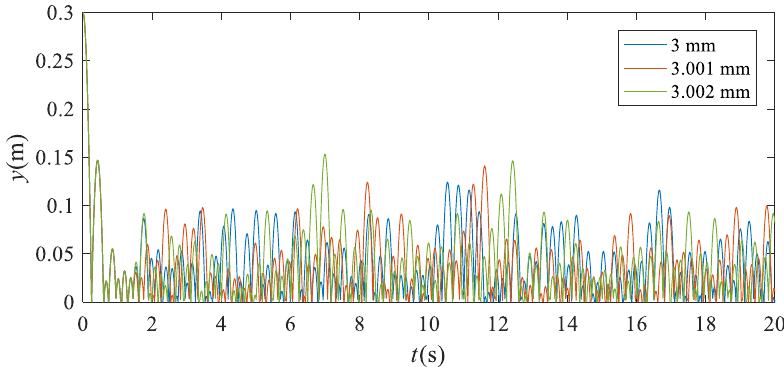
Figure 3. Dynamic responses of particles with different radii.